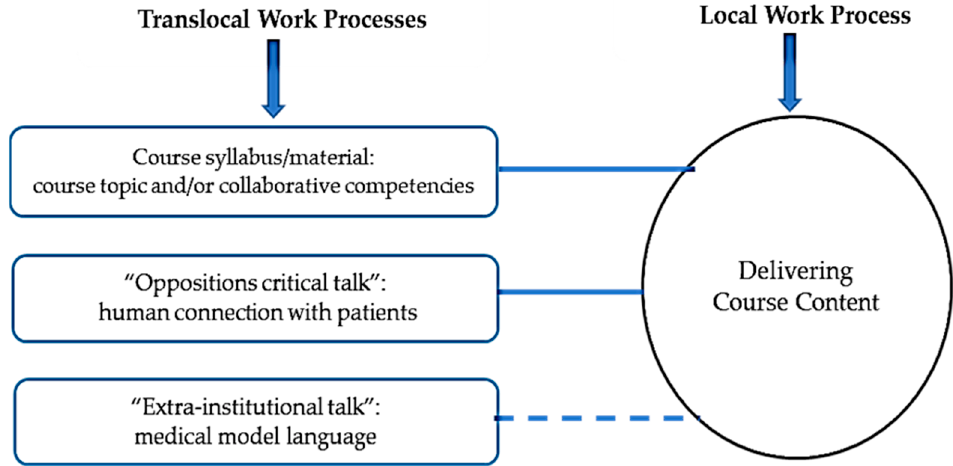
Figure 4. Delivering course content work process.